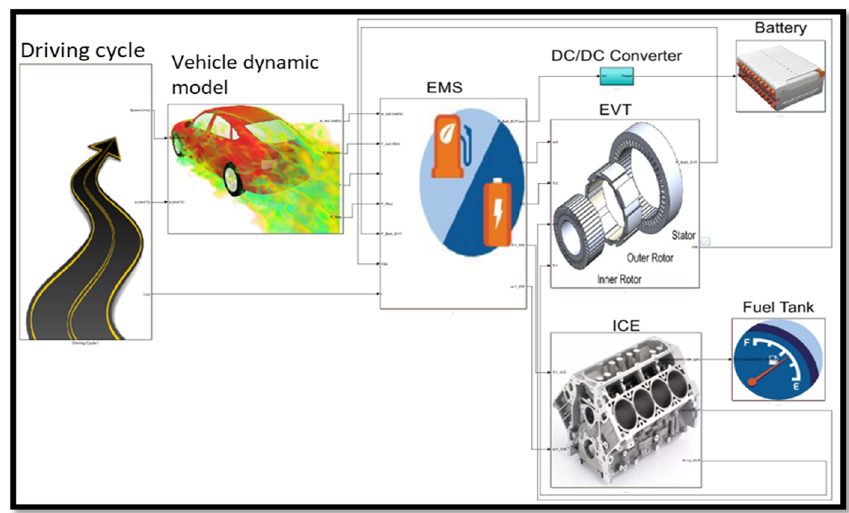
Figure 4. Diagram of the backward calculations modelled in a Simulink ® environment.